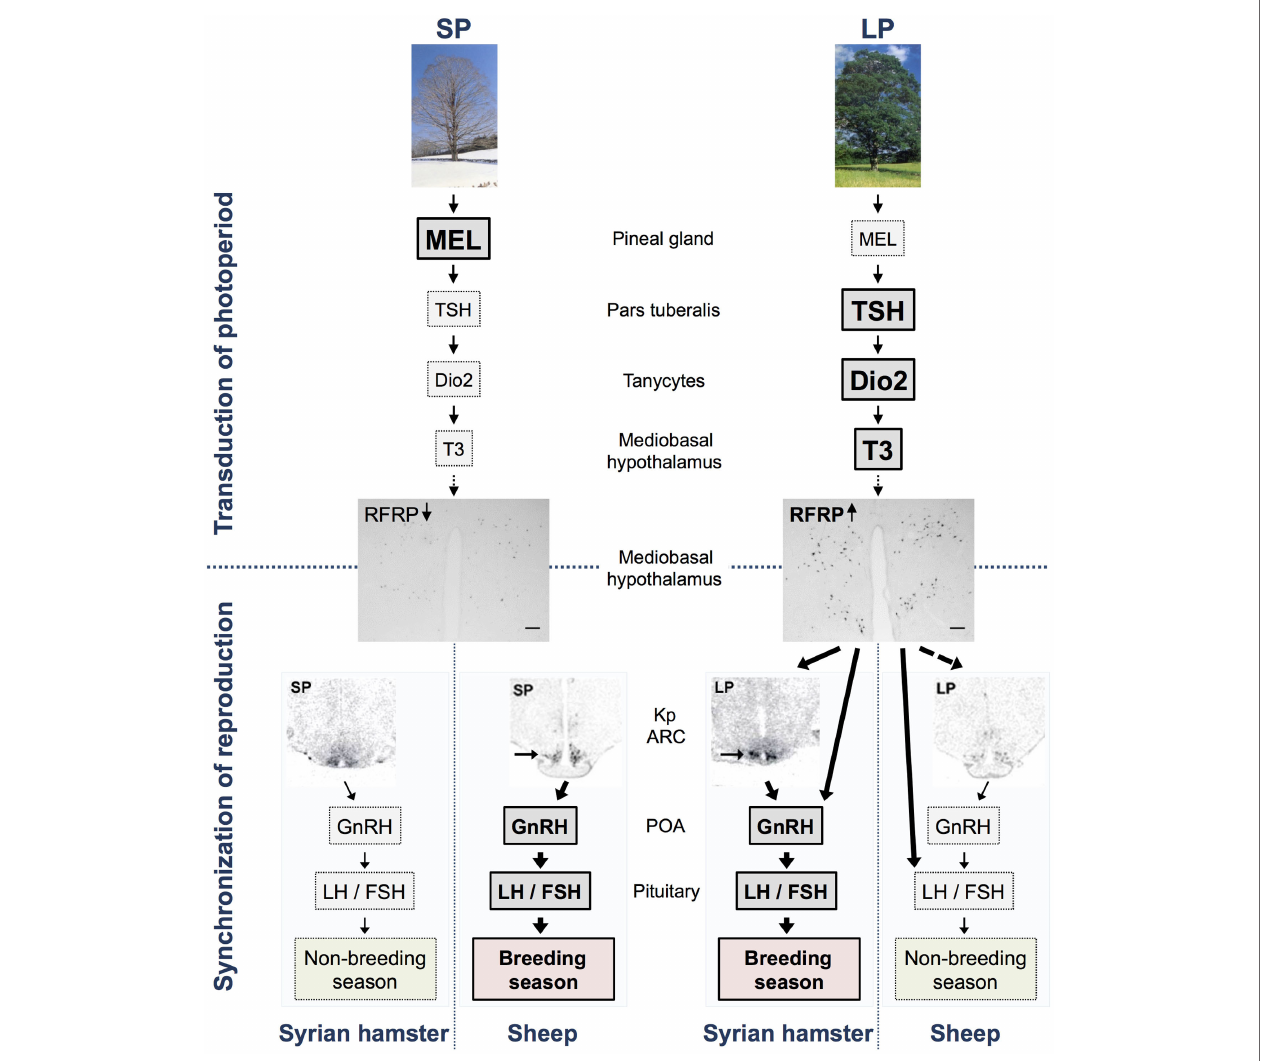
FiGURe 1 | Model of the transduction of photoperiod and seasonal regulation of the reproductive axis in long (Syrian hamsters) and short day (sheep) breeders . In short photoperiod (SP), the large production of melatonin from the pineal gland inhibits TSH synthesis in the pars tuberalis , whereas the lower production of melatonin in long photoperiod (LP) allows the synthesis and release of TSH. TSH is transmitted via TSH receptors expressed in tanycytes surrounding the third ventricle and activates the enzyme deiodinase 2 (Dio2). Dio2 ultimately controls and increases the local availability of the active form of the thyroid hormone, T3, in the mediobasal hypothalamus. Subsequently, T3 regulates the expression of RFRP also in the mediobasal hypothalamus so that there is a high expression in LP and a low expression in SP in both LP and SP breeders, as demonstrated with pictures of RFRP-ir neurons in brains from Syrian hamster kept in LP and SP [scale bar 100 μ m, taken from Ref. (59)]. In Syrian hamsters, RFRP subsequently acts either directly on GnRH neurons or indirectly via kisspeptin (kp) neurons (indicated by arrows) or other interneurons in the arcuate nucleus (ARC) to synchronize reproduction with season. In sheep, RFRP regulates the reproductive axis directly at the level of the pituitary (indicated by arrow) and possibly also directly or indirectly via kp neurons (indicated by dotted arrow) and/or GnRH neurons. Expression of the gene encoding kp in the ARC displays an opposite photoperiodic regulation in the two species being elevated in both LP-adapted sexually active Syrian hamsters [see arrow in picture taken from Ref. (33, 60)] and SP-adapted sexually active sheep [see arrow in picture taken from Ref. (61)]. This model does not describe specific effects of RFRP-3 reported in each species, sex, and photoperiod, and readers are referred to Table 1 for a detailed summary.